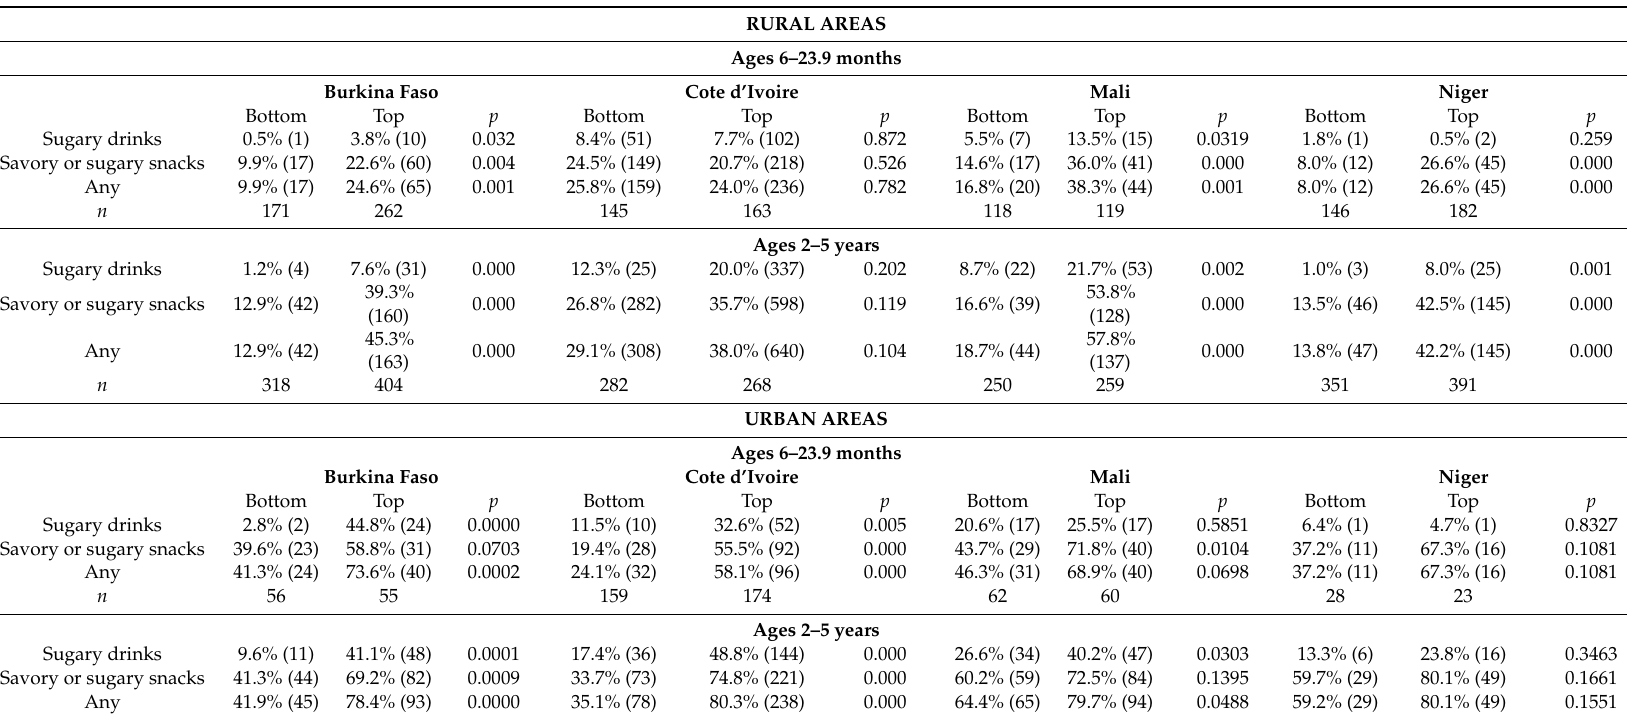
Table 4. Percentage of children consuming commercial snack foods in past 24 h by wealth quartile in rural and urban